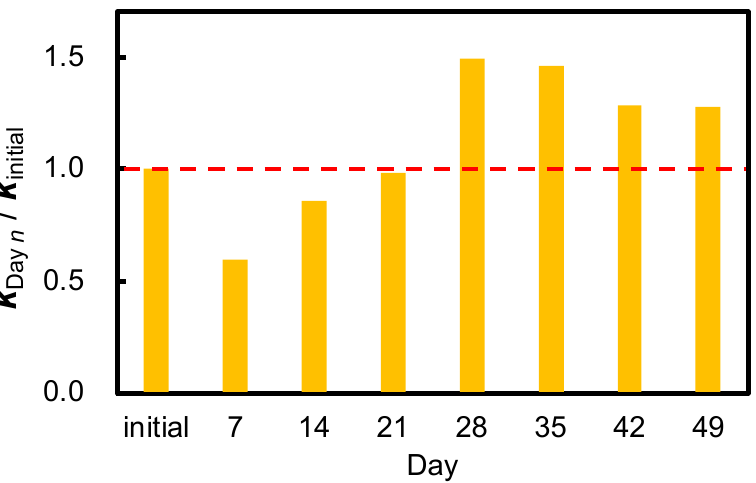
Figure 8. Effects of 49-day outdoor exposure on the rate of photocatalytic degradation of MB.